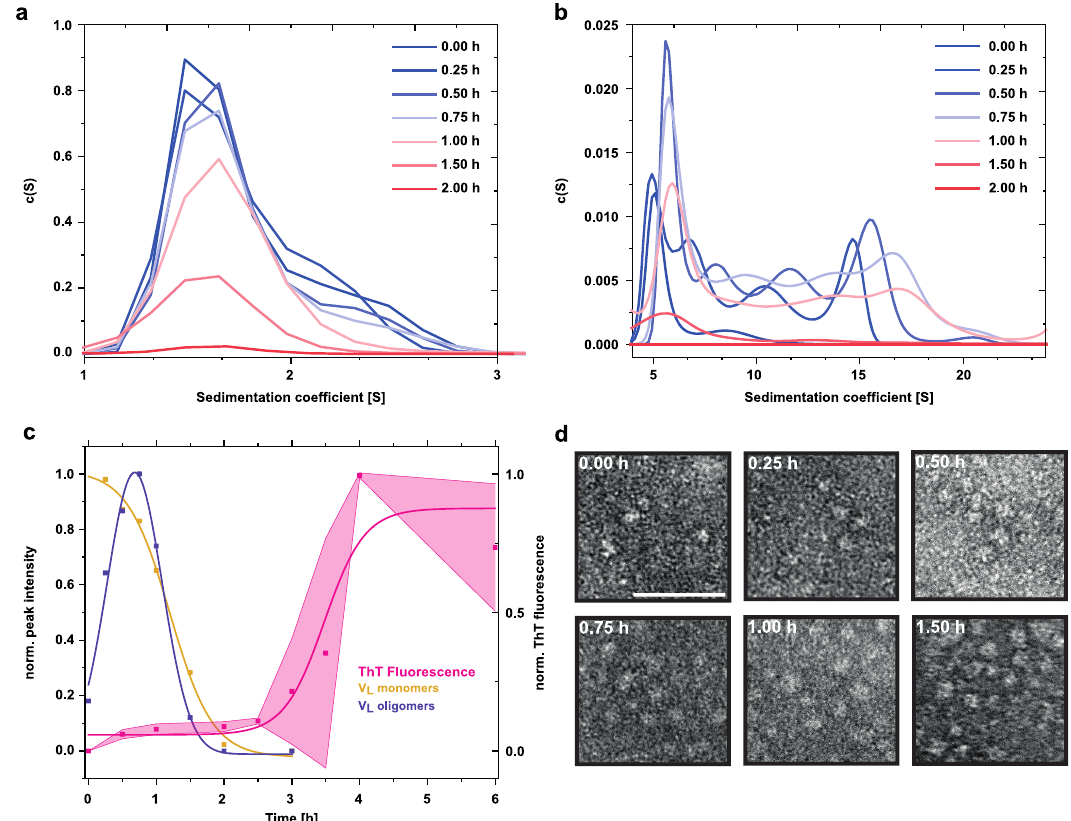
Fig. 2 Oligomeric species present in the lag phase of the amyloid pathway of Pat-1 V L . AUC sedimentation pro fi les over time of a monomeric and dimeric species and b oligomeric species. c Normalized AUC peak quanti fi cation of monomeric (yellow) and oligomeric (purple) species during the lag phase of fi bril formation. The data for monomeric species were fi t to a Boltzmann function, the data for oligomeric species were fi t to a Gaussian function. Shade of the ThT Fluorescence represents the SEM of n = 3. d Section of TEM micrographs shown in Fig. S5 of the oligomer and fi bril formation over time. Scale bar represents 50